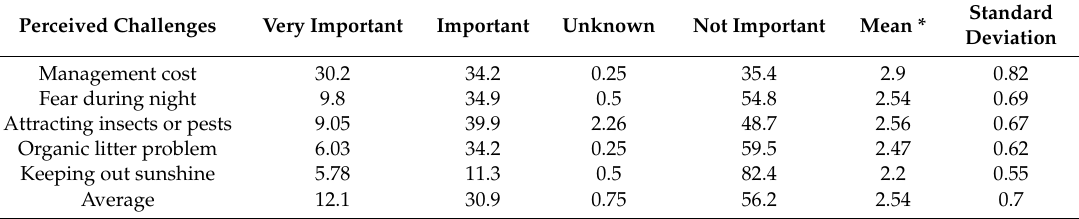
Table 4. Percentage value of residents’ perception of the challenges of neighborhood parks.